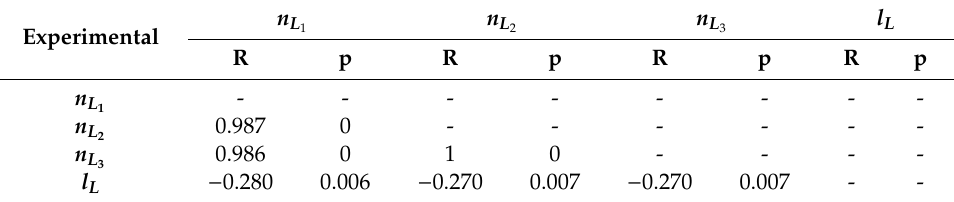
Table 5. Covariance (correlation and probability) values for experimental data.